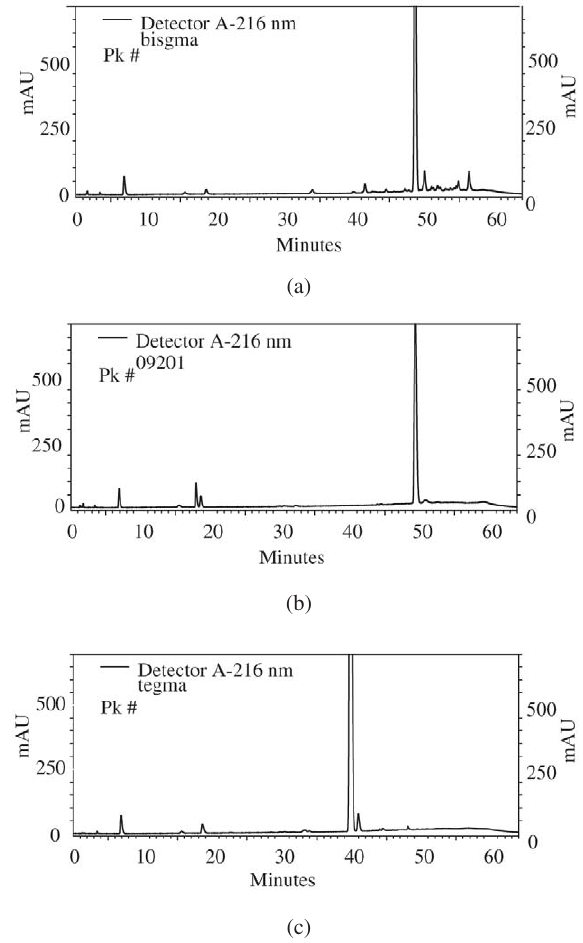
Figure 2. a) Chromatograms of Bis-GMA; b) UDMA; c) TEGDMA patterns.